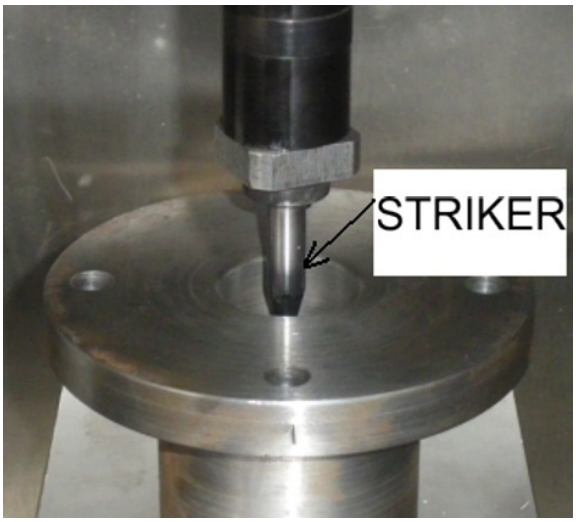
Figure 4. Striker used in impact tests.